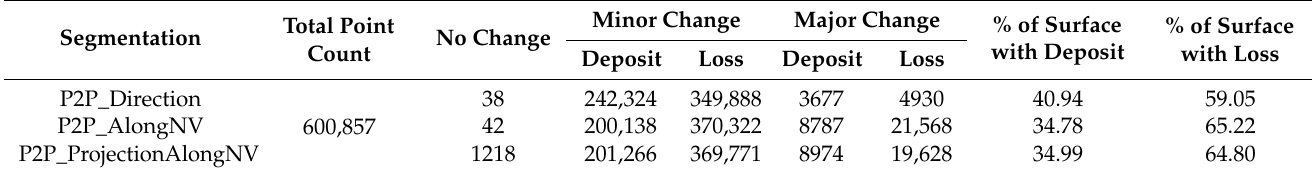
Table 22. Analysis of surface points count on the surface of NGS1.